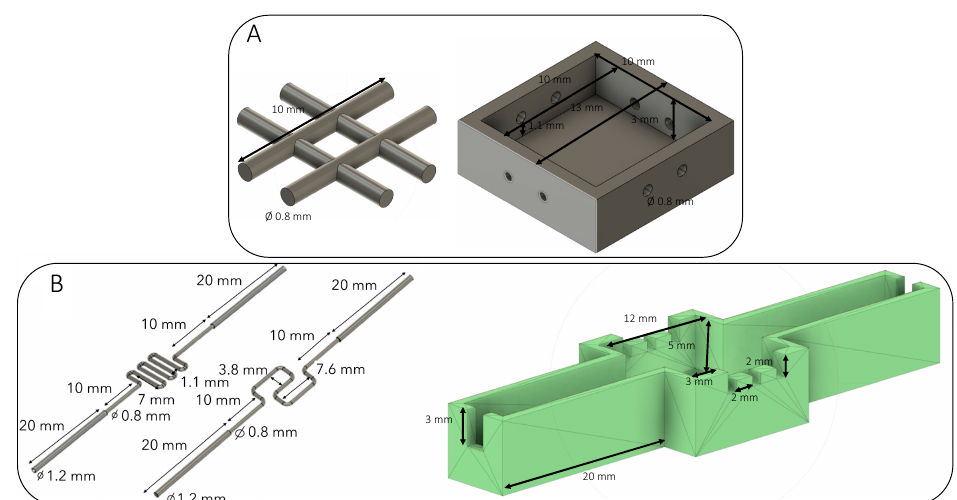
Table 1. Sacrificial material tested and their associated solvents.